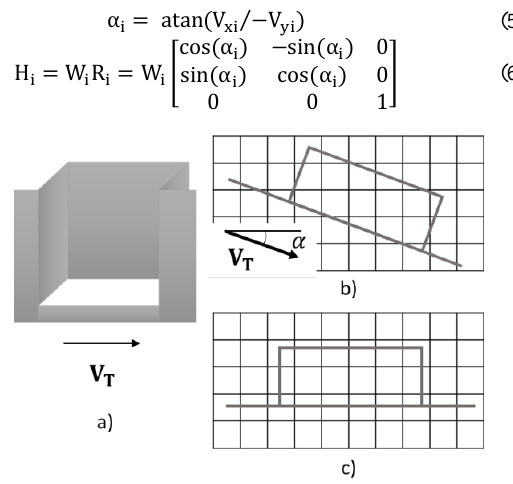
Figure 5. Normal estimation in a vertical (a) and inclined (b) element. In green, vector associated to vertical points; in blue, inclined; and in yellow, horizontal .